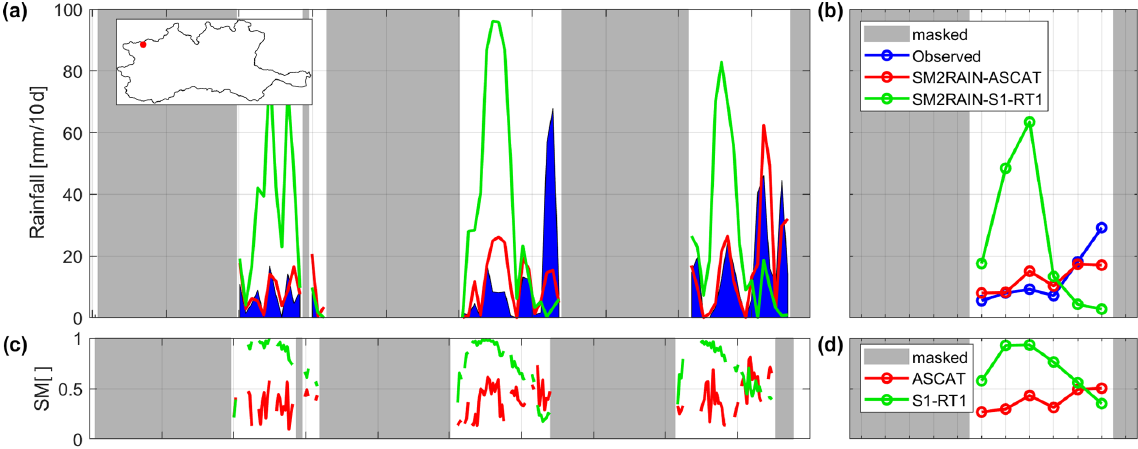
Figure 6. Example of SM and rainfall time series over a pixel (7.410 ◦ E, 45.824 ◦ N) where the parameterized SM2RAIN-ASCAT outper- forms SM2RAIN applied to S1-RT1. In (a) , the time series of the observed (blue) and estimated (red SM2RAIN-ASCAT, green SM2RAIN- S1-RT1) 10d accumulated rainfall products are shown, while panel (c) displays SM time series averaged with a 3d window. Finally, panels (b) and (d) contain the standard month average of the rainfall and SM products, respectively. The periods masked for frozen soil conditions or snow cover are highlighted in